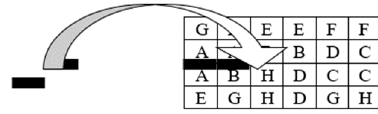
Figure A1. Example of game board.